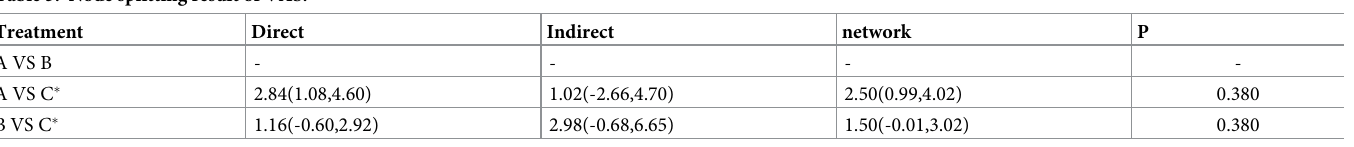
Table 3. Node splitting result of VAS.